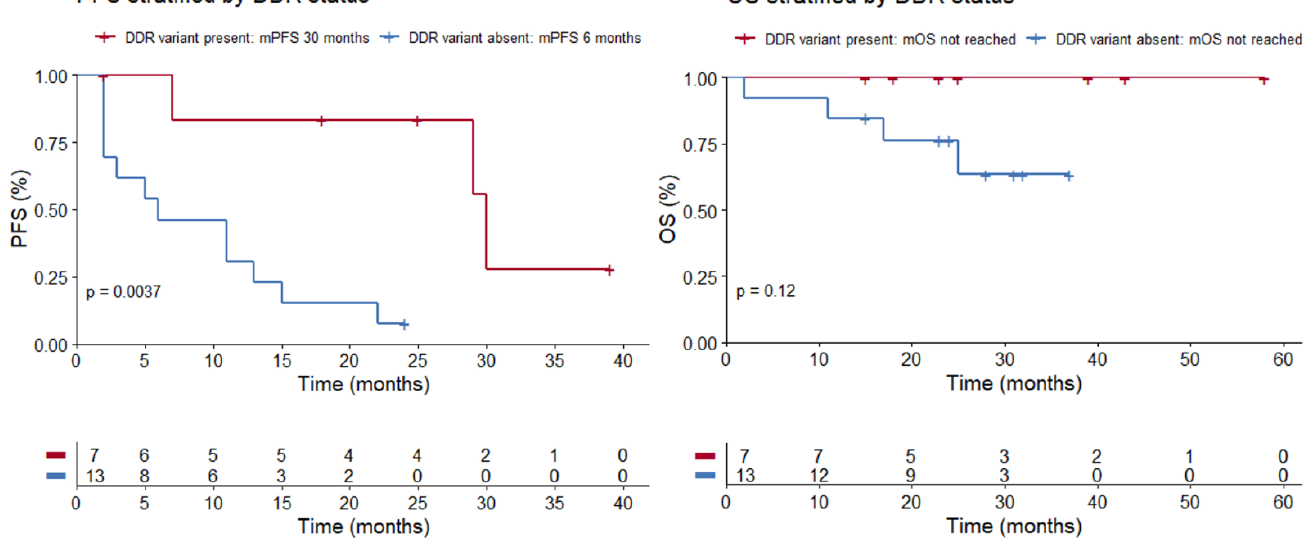
Abbreviations: DDR = DNA damage response.